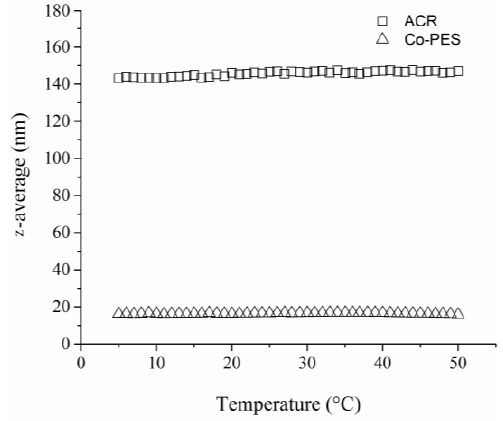
Figure 7. z-average temperature dependence of modified ACR dispersion ( squares ) and Co-PES dispersion ( triangles ).